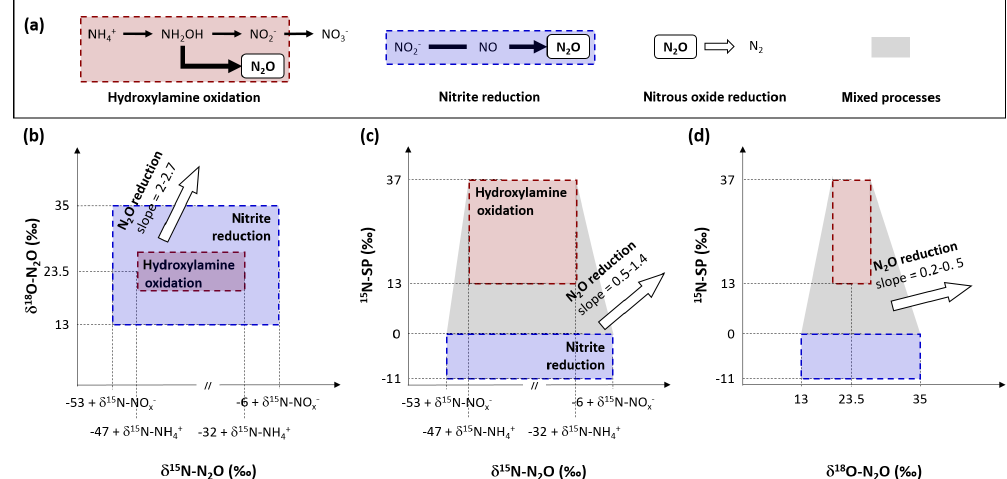
Figure 1. N 2 O-producing and N 2 O-consuming pathways at play during nitrification and heterotrophic denitrification. Substrate isotope composition, isotope effects and 15 N-SP values from the literature were used to propose the ranges of 15 N (Lewicka-Szczebak et al., 2014; Sutka et al., 2006, 2008; Yamazaki et al., 2014), 18 O (Andersson and Hooper, 1983; Hollocher et al., 1981; Kool et al., 2007; Kroopnick and Craig, 1972; Snider et al., 2012) and 15 N-SP (Frame and Casciotti, 2010; Jung et al., 2014; Sutka et al., 2006; Yamazaki et al., 2014), as well the slopes relating them with each other during N 2 O reduction to N 2 (Jinuntuya-Nortman et al., 2008; Webster and Hopkins, 1996; Yamagishi et al., 2007). The assumptions made and the calculations performed are detailed in the